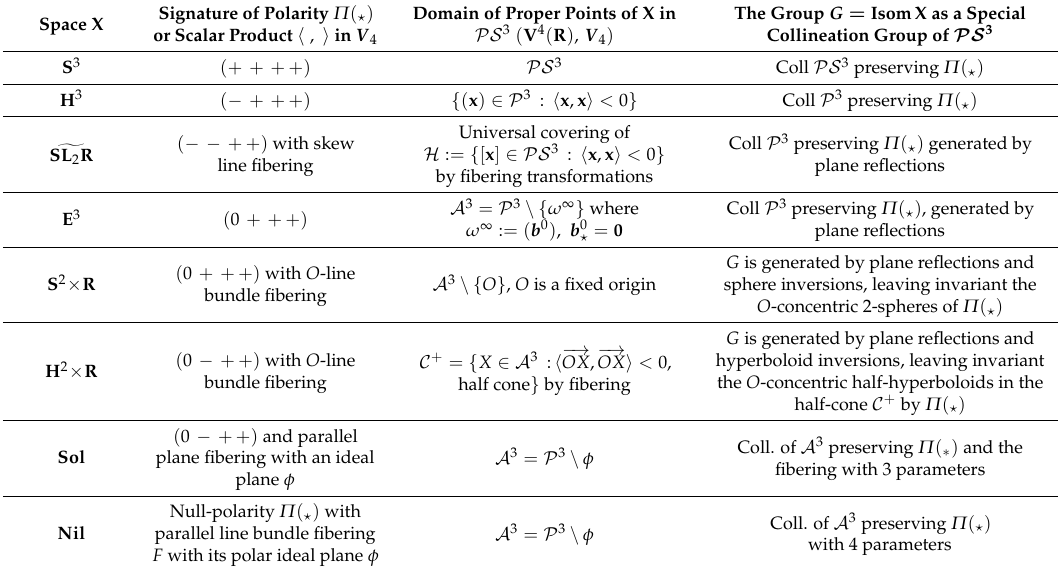
Table 1. Thurston geometries each modelled on PS 3 by specified polarity or scalar product and isometry